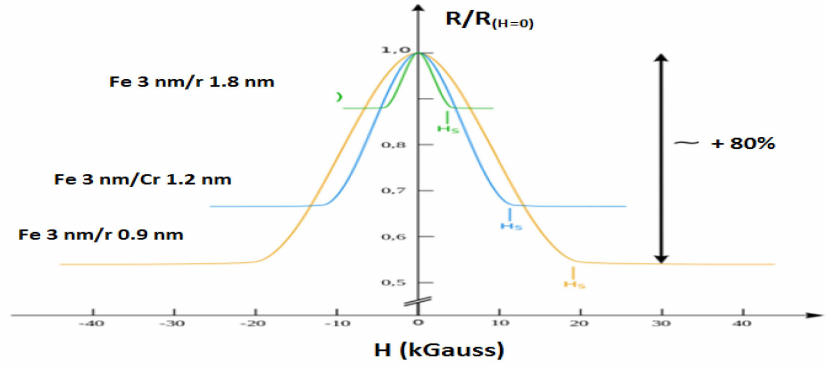
Figure 2. Magnetoresistance of three Fe/Cr superlattices at 4.2 K with different thickness by Baibich et al.